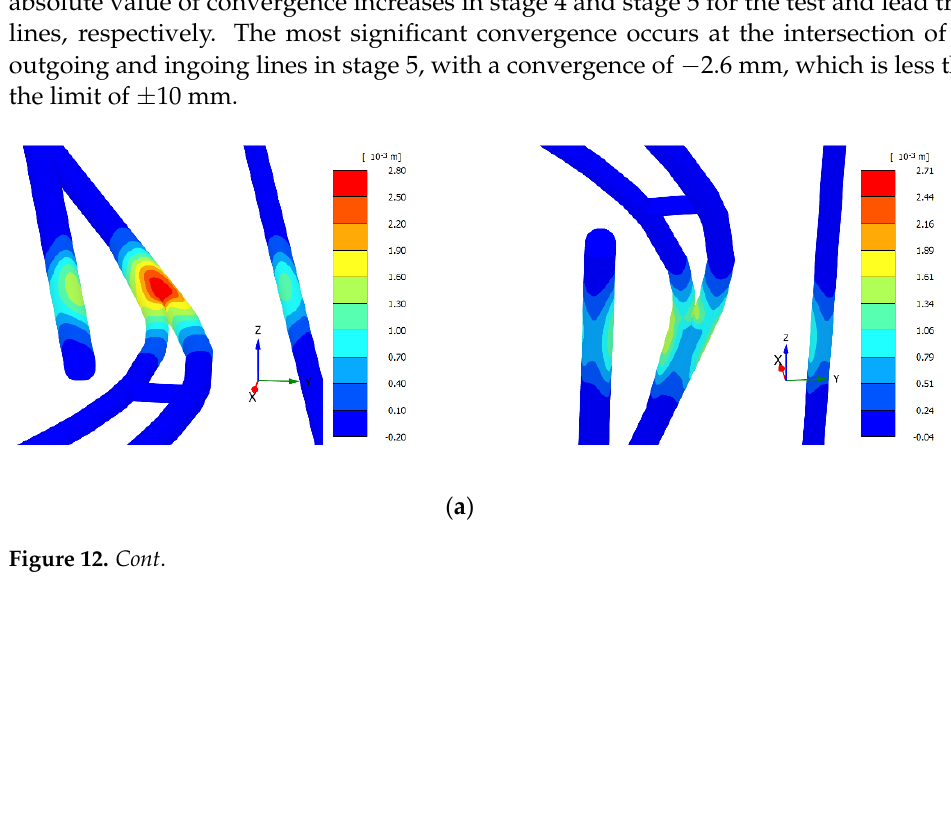
Figure 11. Nephogram of the horizontal displacement (y-direction) of the tunnels: ( a ) stage 3, ( b ) stage 4, ( c ) stage 5.